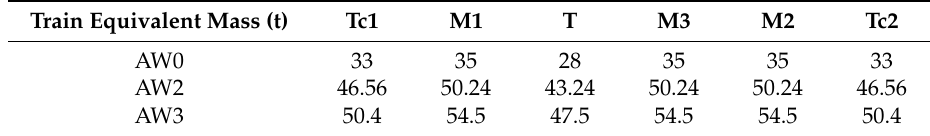
Table 1. Train equivalent mass of Beijing Yizhuang subway line with different load cases. Train Equivalent Mass (t)